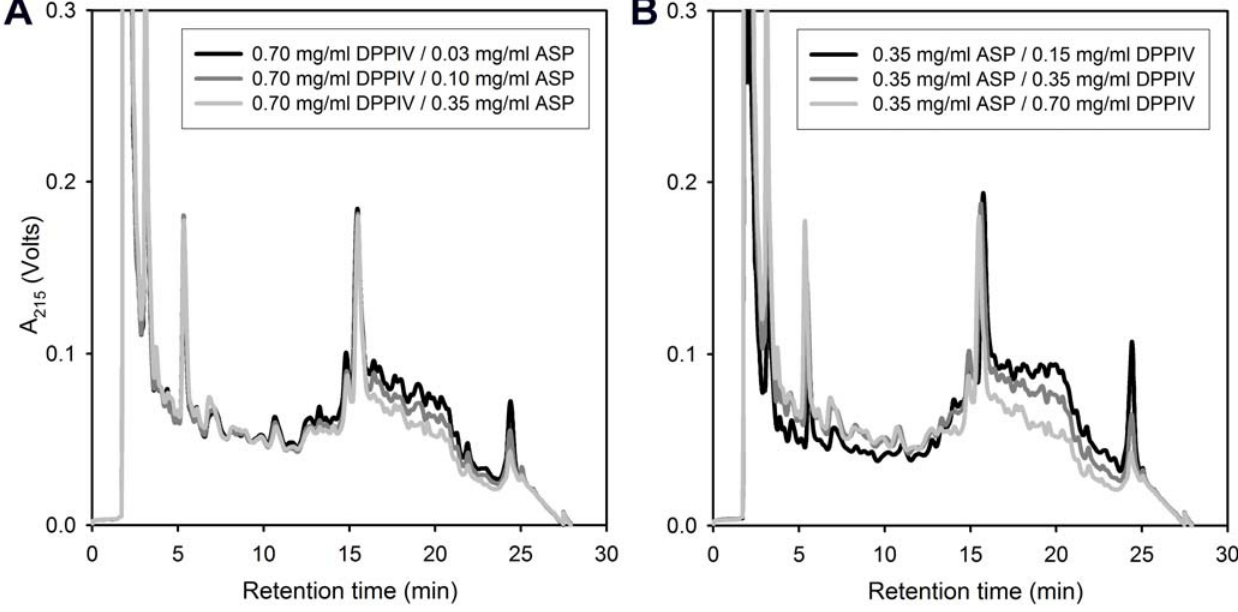
Figure 7. Dose dependence of gluten proteolysis on aspergillopepsin (ASP) and dipeptidyl peptidase IV (DPPIV). Whole gluten powder (50 mg/ml) was incubated for 60 minat 37 u Cwith 0.7 mg/ml DPPIVand variable ASPconcentration(A) or 0.35 mg/ml ASP and variable DPPIV concentration (B). The reactions were conducted in 0.03 M HCl in the presence of 3 mg/ml CaCO 3 . The peak at 15 min corresponds to an internal standard (TAME).